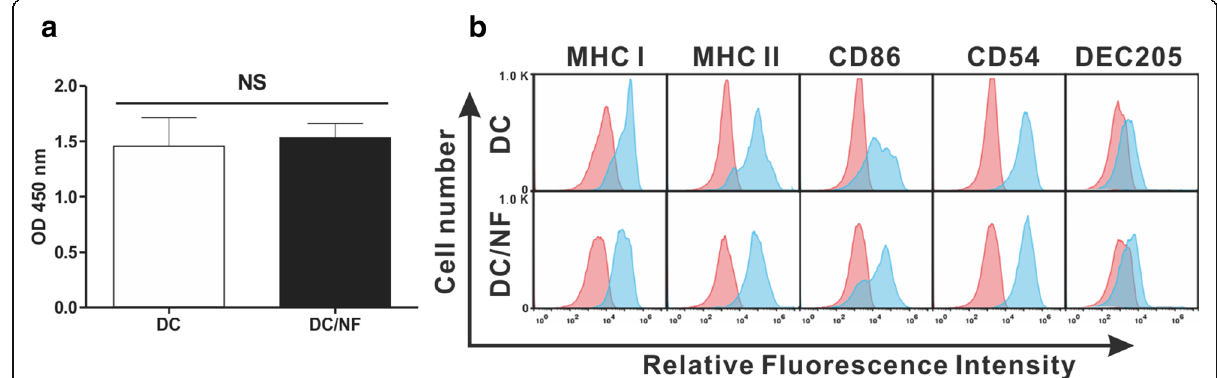
Fig. 3 Effect of hNIS transduction on DC function. a Cell proliferation rates of parental DC and DC/NF cells. No significant difference was observed in the proliferation rate of the two cell lines. b Phenotypic analysis of parental DC and DC/NF cells. Cells were stained with PE- conjugated CD54, CD86, and H-2Kb (MHC class I) and I-A/I-E (MHC class II) and APC-conjugated CD205 (DEC-205), respectively. Red histograms represent isotype control. Data are expressed as mean ± SD; n = 5